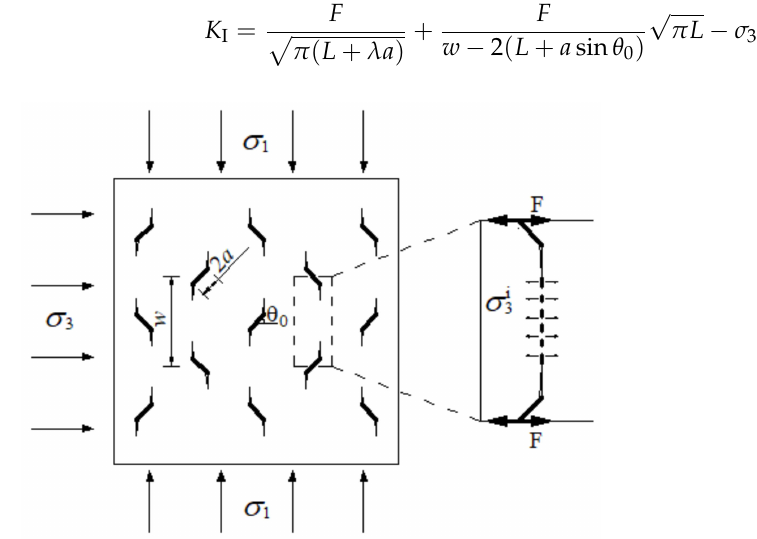
Figure 1. Wing crack propagation under the interaction of multiple